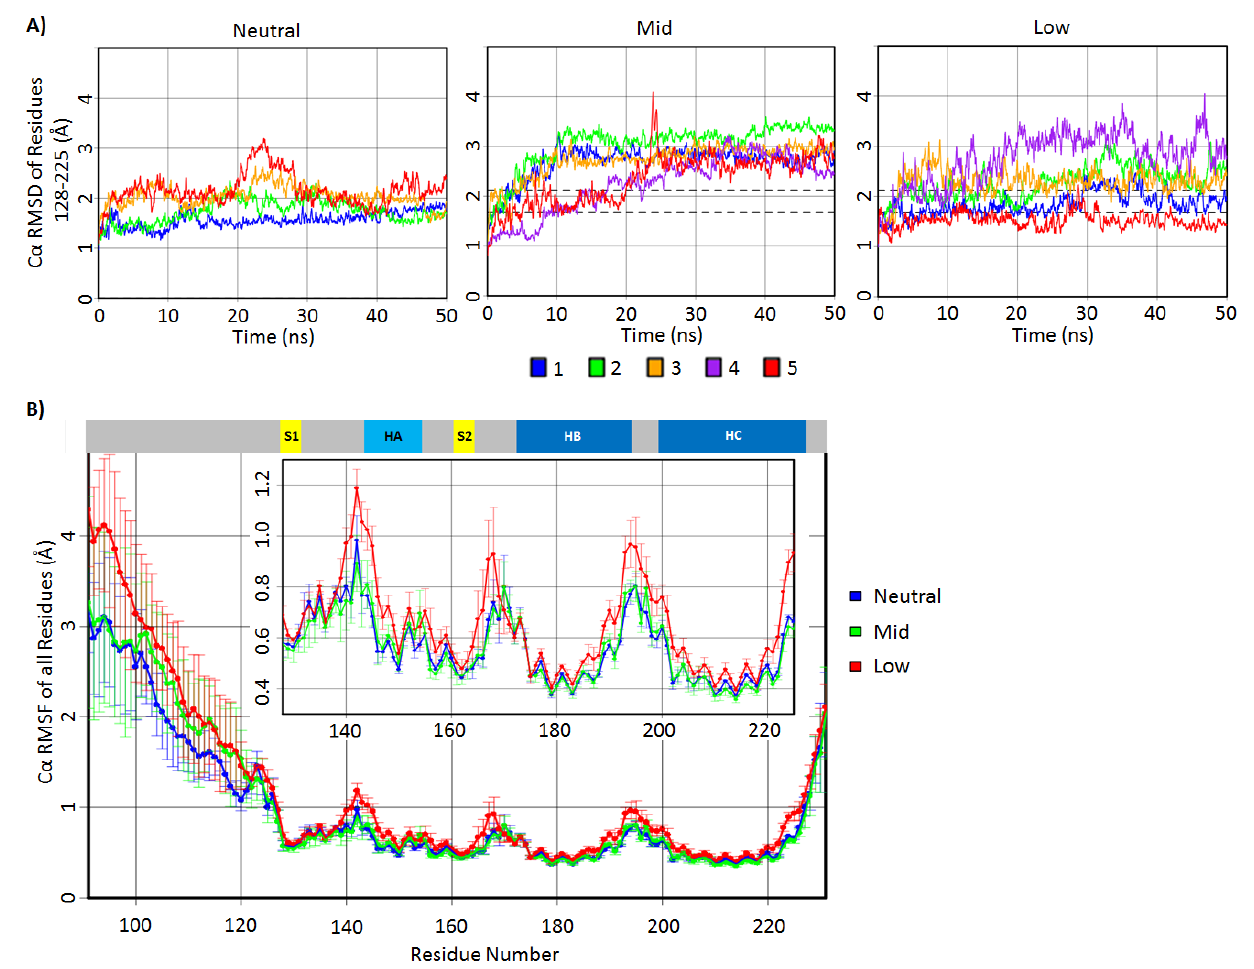
Figure 2. Cα root-mean-square deviation (RMSD) and root mean square fluctuations (RMSF) of the bovine PrP simulations. (A) Residue 128–225 Cα RMSD of the neutral, mid- and low pH simulations plotted over time. The area in between the dotted lines is within one standard deviation of the 25–50 ns averaged Cα RMSD of the neutral pH simulations. (B) Averaged Cα RMSF plotted for all residues in neutral, mid- and low pH simulations. The inset plot shows Cα RMSF for residues 128–225 in a magnified scale. Native secondary structures of the PrP are shown at the top of the Cα RMSF